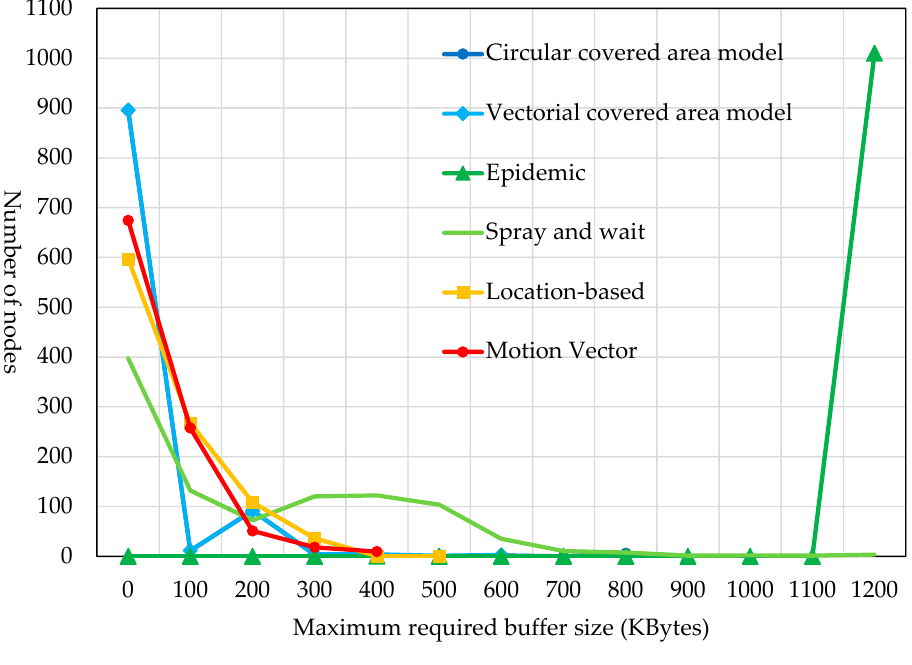
Figure 27. Distribution of the maximum required buffer sizes.